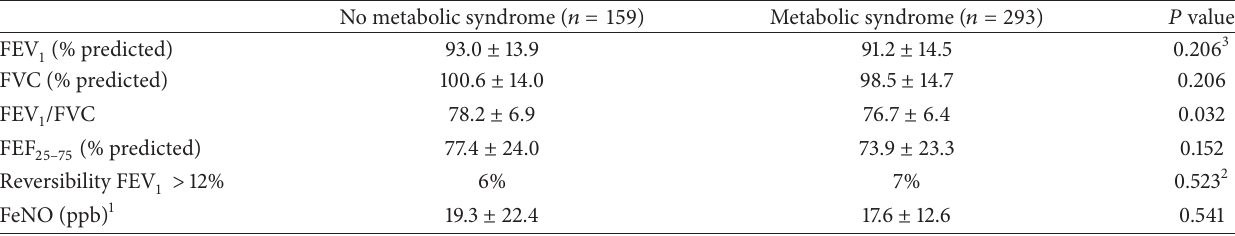
Table 3: Pulmonary function test of subjects with and without metabolic